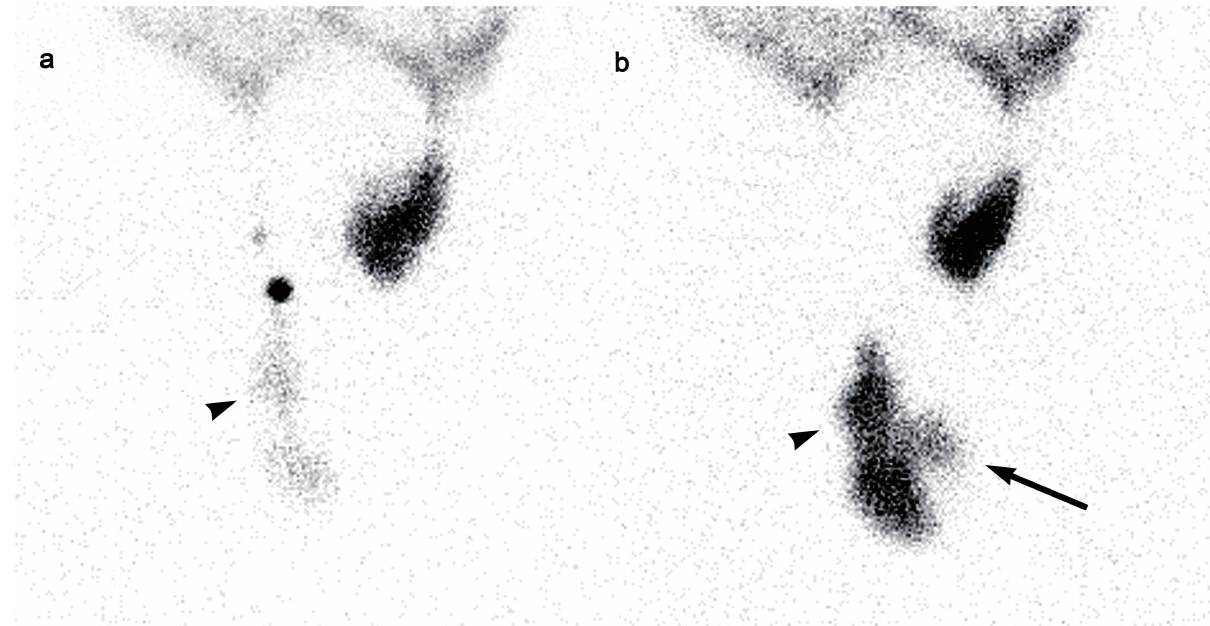
figure 2 - sectorial peritoneal 99mTc-phytate scintigraphy. panel a: post-filling period image revealing the right inguinal and scrotal uptake of radiotracer (head arrow). panel b: post peritoneal lavage image, showing the appearance of left inguinal canal uptake of radiotracer